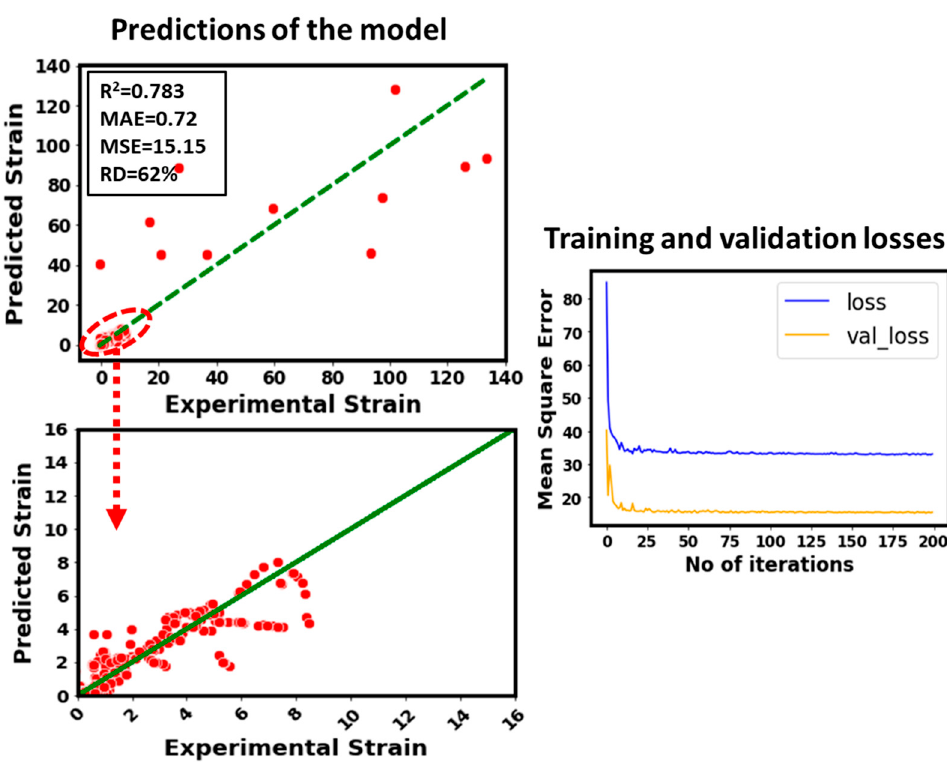
Figure 10. Predictive performance of the developed model by removing relative density from the inputs.